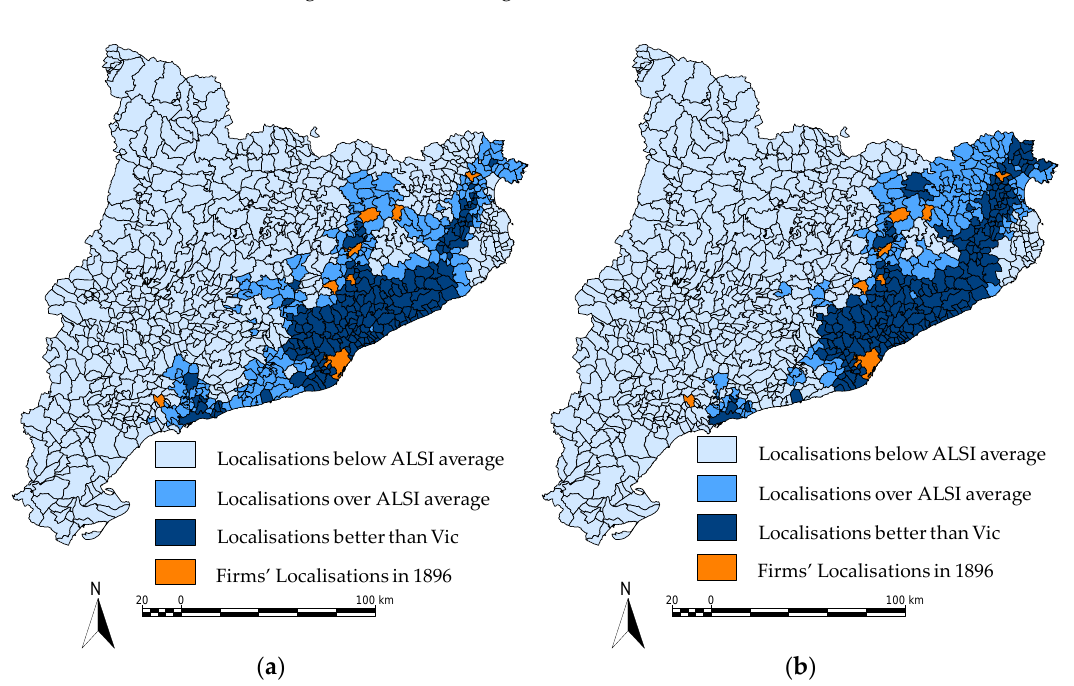
Figure 5. The Weighted Apparent Location Suitability Index (ALSI) and the firms’ location in the Catalan meat-processed industry in the second half of the 19th century. Notes and sources: See Figures 2 and 3. (a) Unweighted ALSI and firms’ location. (b) Weighted ALSI and firms’ location